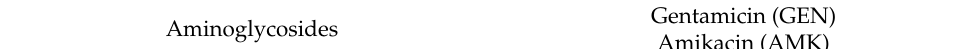
Table 1. List of antibiotics (AB) evaluated in antibiotic susceptibility tests. Aminoglycosides Aminopenicillins +/ − ß-lactam inhibitor Cephalosporins Fluorchinolones and Diazanaphthaline